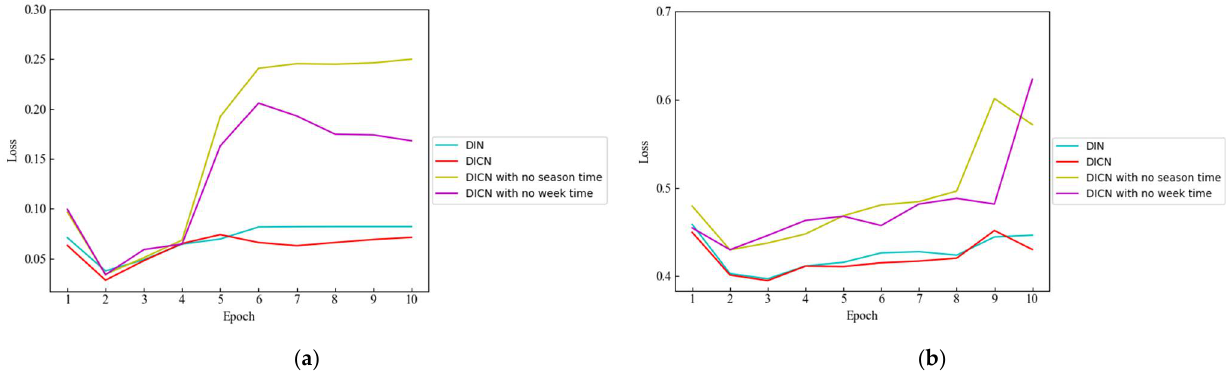
Figure 4. Comparison of model loss under the two datasets. ( a ) Logloss of the Taobao dataset in the test set of the four models. ( b ) Logloss of the Amazon dataset in the test set of the four